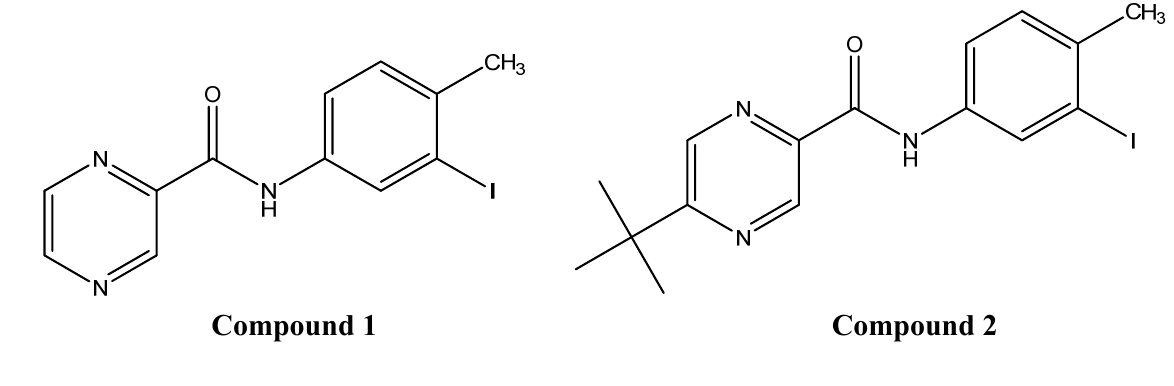
Figure 1. Structures of compounds 1 and 2